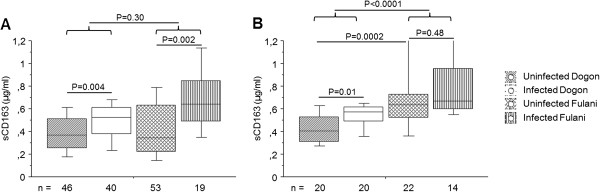
sCD163 in plasma from Dogon and Fulani individuals. Blood plasma samples from 158 individuals were analysed for levels of sCD163. Individuals were divided according to ethnicity and infection status. Levels are shown for A) the total population and B) the children cohort from 2008 (aged two to ten years). The boxes represent the lower quartile (25%) and the upper quartile (75%) with the middle line as the median. The whiskers indicate the 10 and 90% percentiles. Statistical analysis was done with Kruskal-Wallis and Mann–Whitney U test.